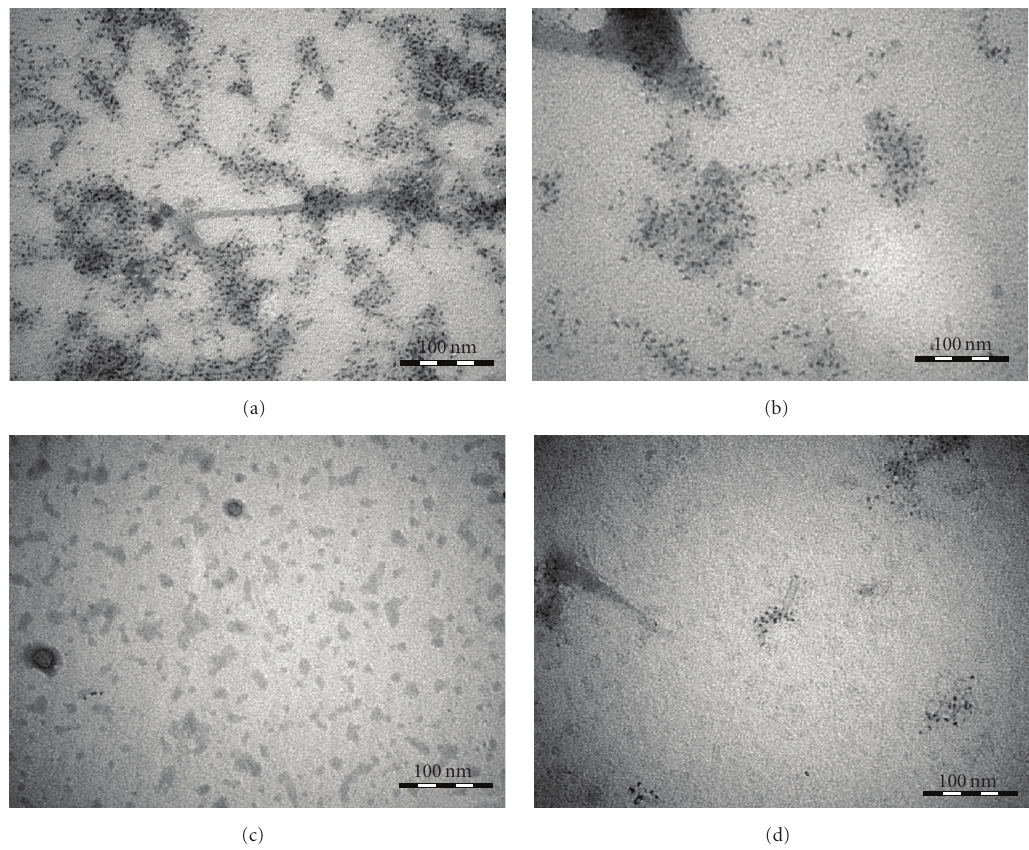
Figure 6: TEM images of the unstained samples of A β (1–42) mixed to DHLA-capped QDs (a), (b) and A β (1–42) conjugated to DHLA- capped QDs (c),